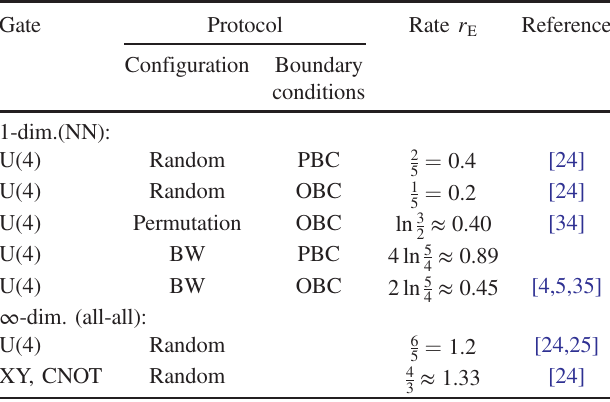
TABLE I. Existing exact results for the purity decay rate r , E t Þ , in qubit random circuits defined as I ð t Þ ∼ exp ð − r E (cf. Fig. 1). Per unit of time, ∼ n gates are applied. Determin- istic 1-dimensional (1-dim.) nearest-neighbor (NN) protocol with a brick-wall (BW) pattern of gates is faster than randomly choosing a NN pair on which the gate acts. Allowing coupling between an arbitrary pair of gates ( ∞ -dim. all-all) is even faster. Results are shown for open boundary conditions (OBC) and periodic boundary conditions (PBC). U(4) denotes a Haar random gate, while the XY gate is also known as the iSWAP or DCNOT